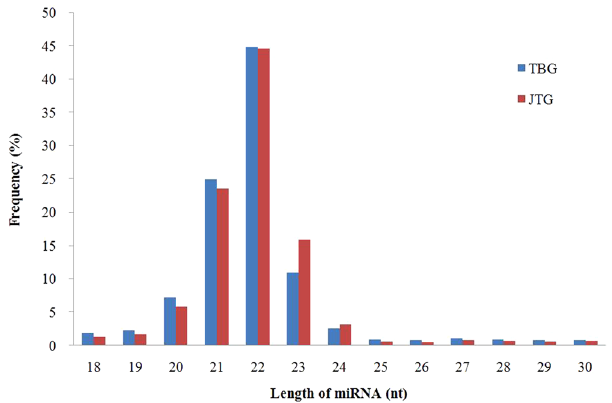
Figure 1. Sequence length distribution in the non-prolific Tibetan goat (TBG) and the prolific Jintang black goat (JTB) ovarian